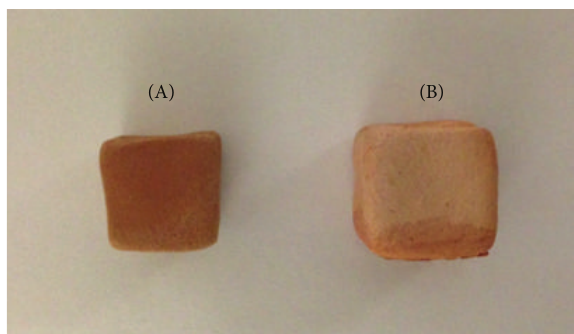
Figure 10: Laboratory samples: sample A: calcite in the mixture of the clay; sample B: absence of calcite in the clay. Both the samples were covered with Fe 2 O 3 powder (hematite phase) and treated at 1000 ∘ C.